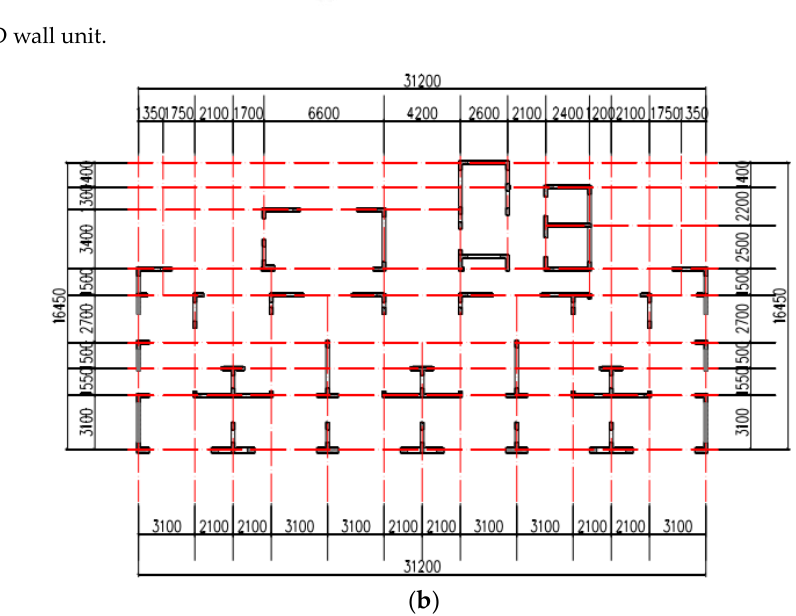
Figure 3. ( a ) Model of assembled shear wall structure; ( b ) Wall and column arrangement of the structure.